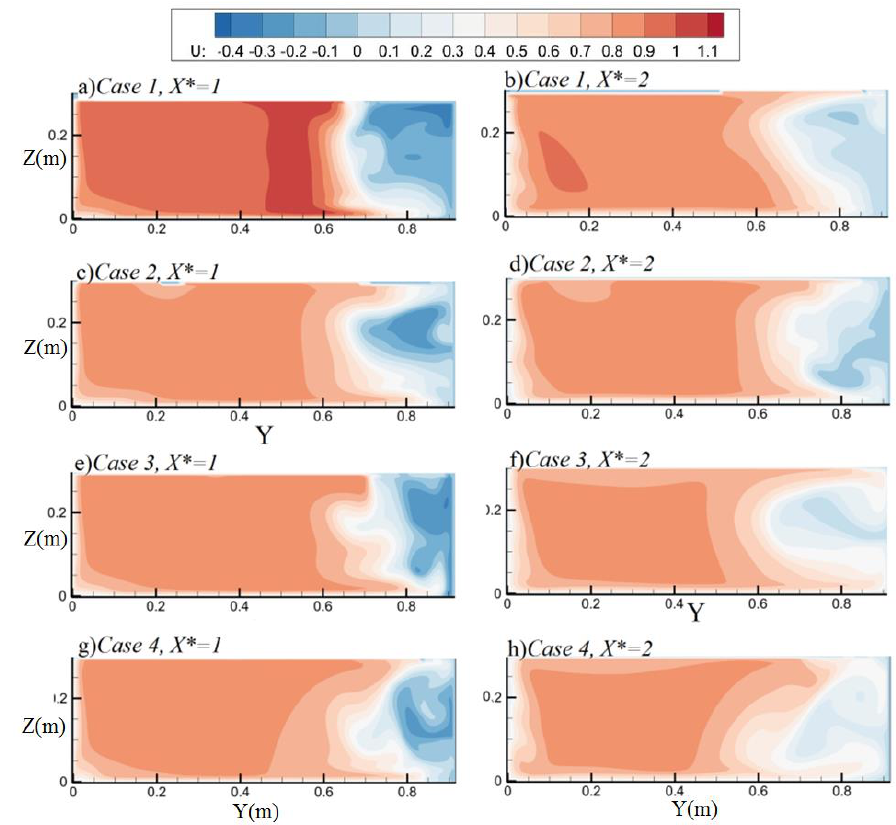
Figure 7. The effect of W* variations on the distribution of U in transverse plane. Figure 7. The e ff ect of W* variations on the distribution of U in transverse